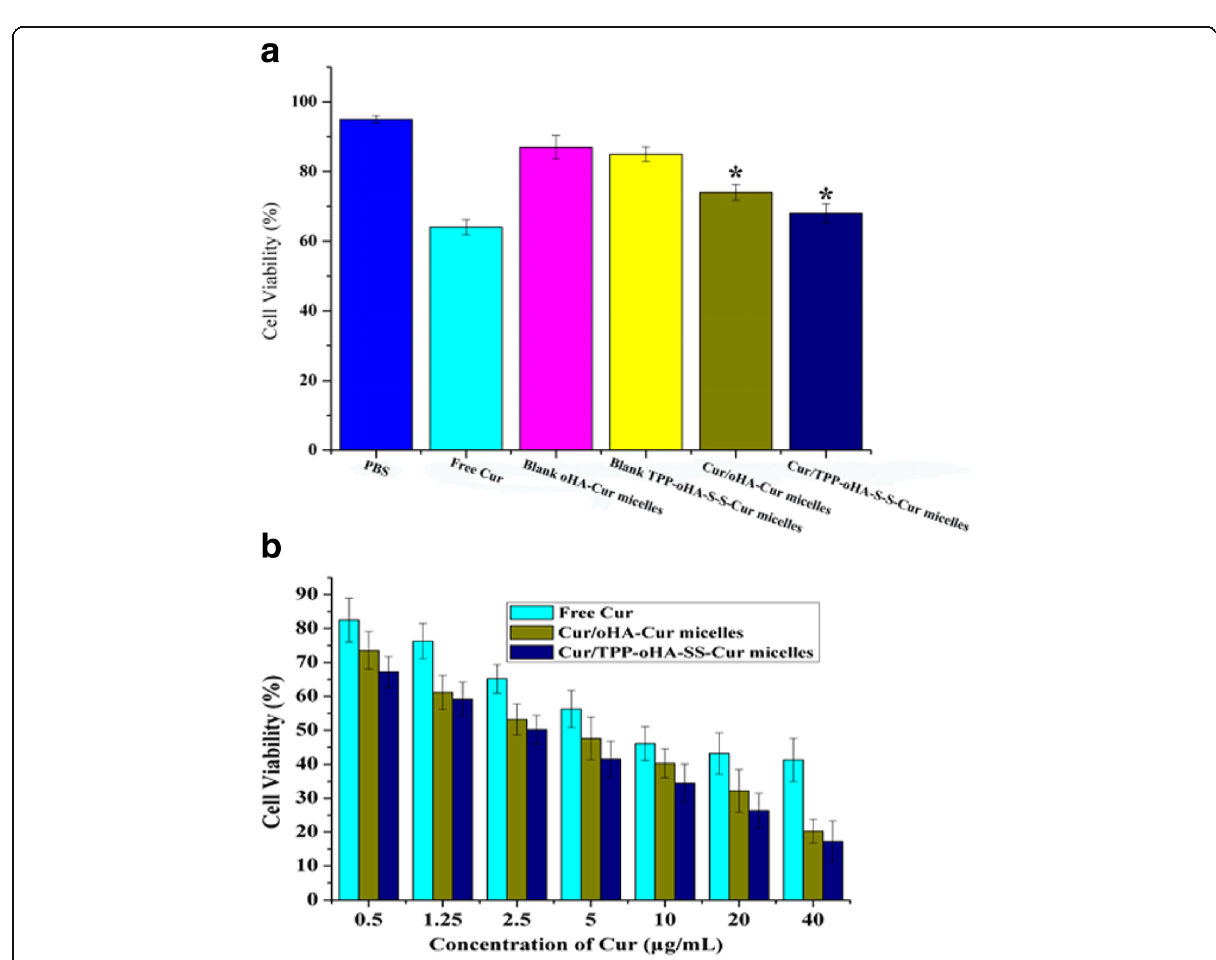
Fig. 6 a Cytotoxicity of curcumin formulations after incubation for 24 h. Data represent the mean ± SD ( n = 6). * p < 0.05, compared with the free Cur. b Cytotoxicity of Cur-loaded micelles with different concentrations of Cur (0.5, 1.25, 2.5, 5, 10, 20, and 40 μ g/mL). The IC 50 values of free Cur, Cur/oHA-Cur micelles, and Cur-TPP-oHA-SS-Cur micelles were 6.534, 5.092, and 3.871 μ g/mL, respectively